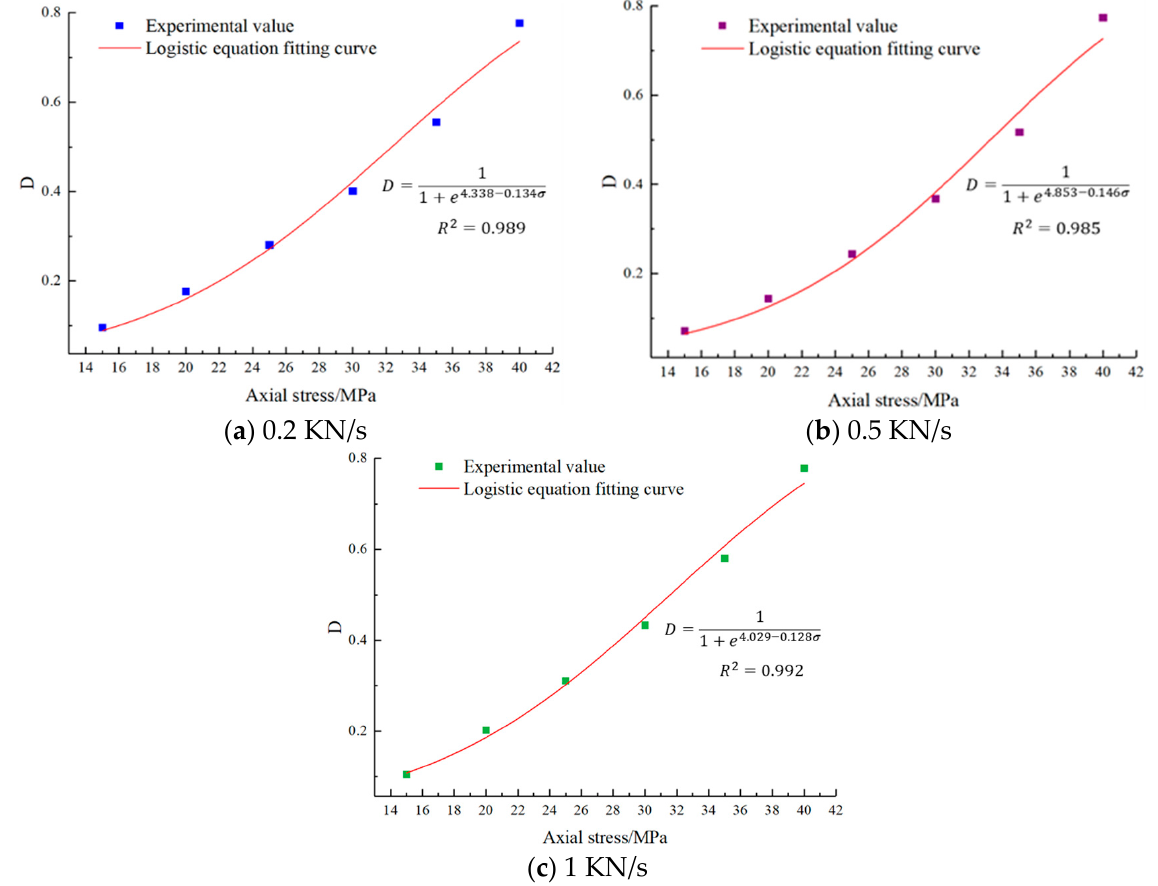
Figure 13. Damage evolution fitting curve.